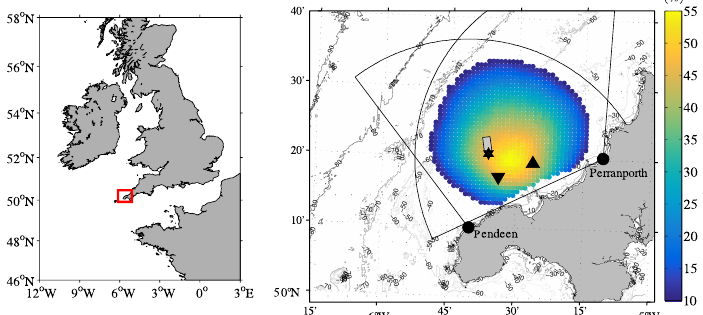
Figure 1. Study area: ( right ) the red rectangle demarcates the area shown in left figure, ( left ) radar stations (black circles), their coverage (50 km radius fans) and measuring grid. Depth contours are also shown and expressed in meters. The temporal data coverage of each radar cell is shown as a percentage of the time each cell had inverted wave data. The in situ mooring devices are also depicted: wave buoy (star), ADCP-W (inverted triangle) and ADCP-E (triangle). The grey rectangle delimits the Wave Hub test site for marine renewable energy